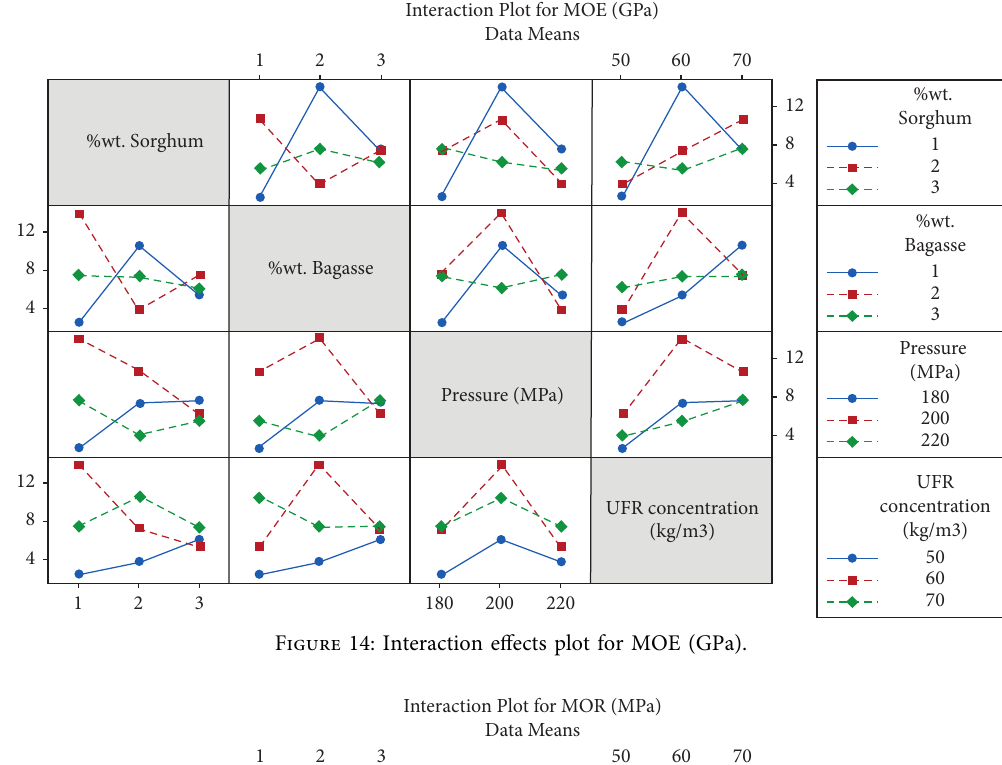
Figure 14: Interaction effects plot for MOE (GPa).